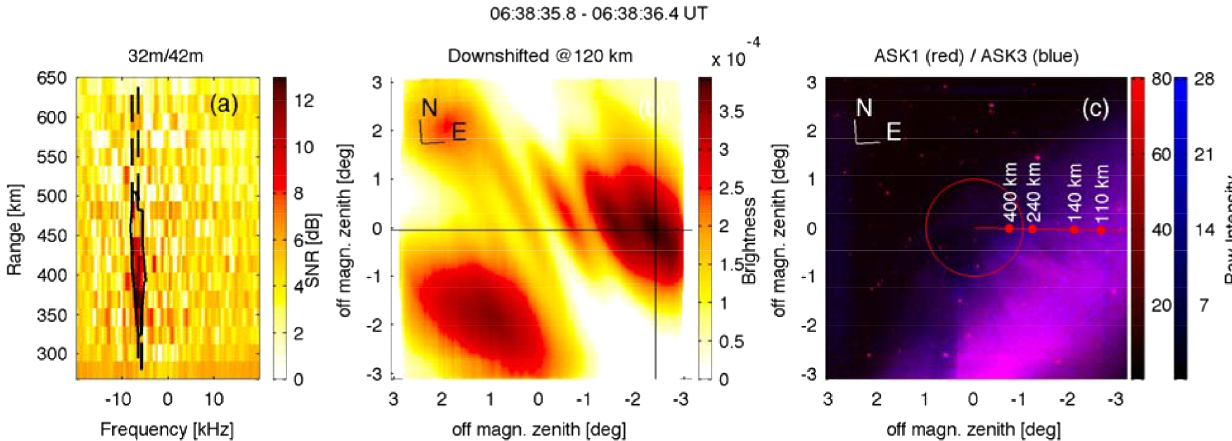
Figure 6. Radar and optical data for the time period 06:38:35.8–06:38:36.4UT. Panel (a) shows the magnitude of the cross-spectrum of the 32m/42m baseline at 600ms time integration and range gates of 22 . 5km. The down-shifted ion line backscatter distribution mapped to an altitude of 120km is shown in panel (b) . The north and east directions are depicted in the upper left corner of the panel. Panel (c) shows a false color image of combined ASK1 and ASK3 data integrated over the same time period. The red circle indicates the main lobe of the 42m antenna. The red line indicates the magnetic field line passing through the maximum backscattered power in (b) . Tick marks along the field line indicate